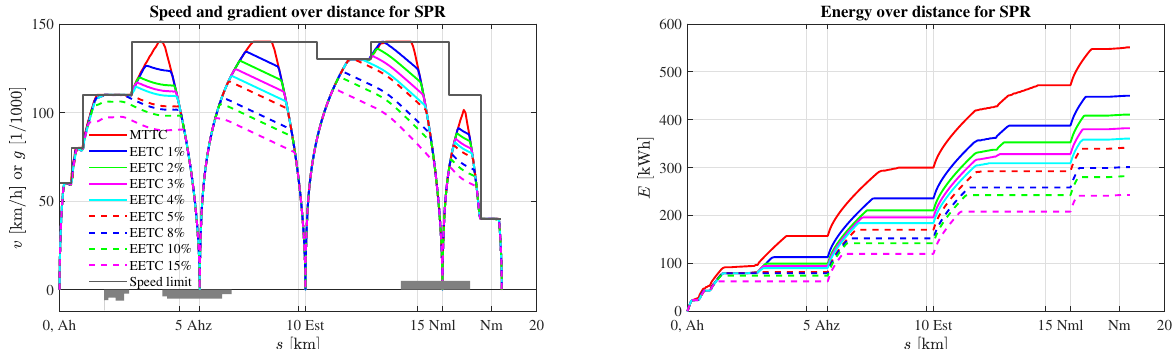
Figure 5: The left plot shows for the case Ah-Nm SPR with varying running time supplements the speed/gradient–distance profile of the MTTC and EETC driving strategies. The right plot indicates the energy–distance profile of the MTTC and EETC driving strategies for the case Ah- Nm